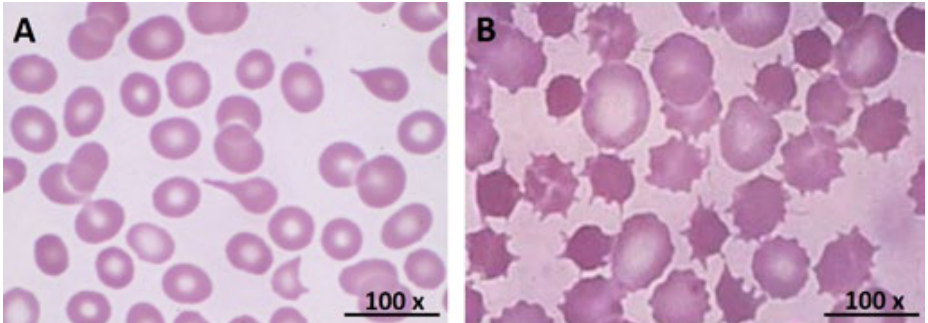
FIGURE 4 - Giemsa stained RBCs (A) Normal (B) Drug loaded showing changes in morphology before and after drug loading